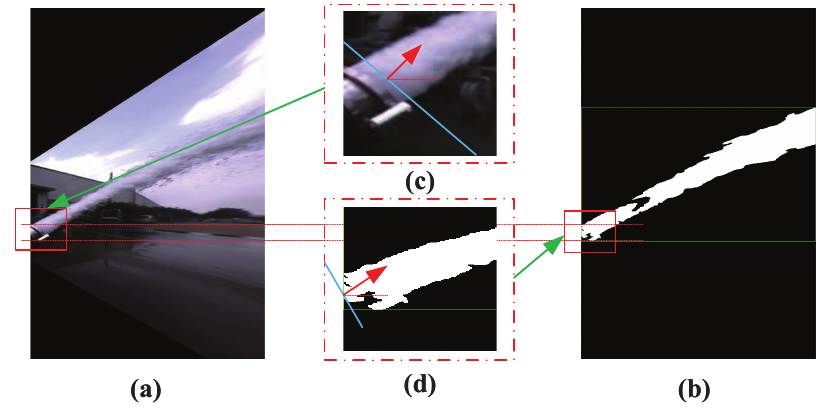
Figure 3. Disturbance in the process of jet trajectory feature extraction. ( a ) trajectory color image; ( b ) trajectory binary image; ( c ) fire monitor head color image, red arrow indicates the trajectory direction; ( d ) fire monitor head binary image, red arrow indicates the trajectory